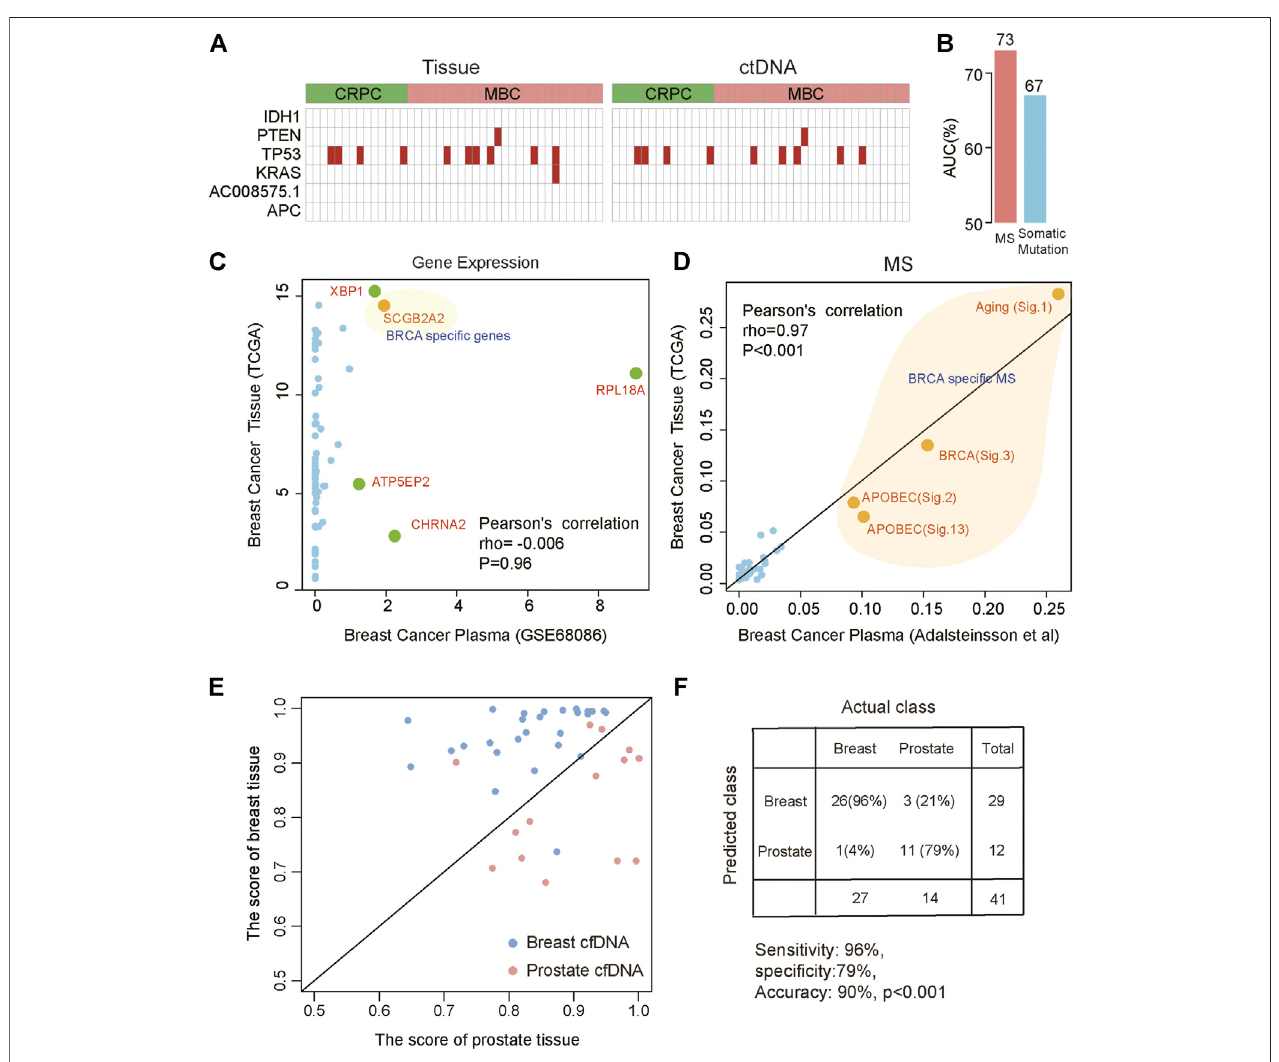
FIGURE 5 | Distinguishing different cancer types based on the MS patterns and somatic mutations called from plasma ctDNA data. (A) The speci fi c mutations in tissue (left) and ctDNA (right). Red indicates that mutation was detected. CRPC: prostate cancer; MBC: metastatic breast cancer. (B) The ef fi ciency of MS and somatic mutations to distinguish lung cancer patients from benign lung nodules patients from ctDNA data. (C,D) The correlation between plasma and tissue in breast cancer based on gene expression (C) and MS (D) . Orange indicates breast cancer-speci fi c markers. (E,F) Combined MS patterns and somatic mutations called from plasmactDNAdatadistinguishbreastcancerandprostatecancer.Theredpointsrepresentprostatecancerandthebluepointsrepresentbreastcancer.Thehorizontal axis represents the score of the prostate cancer model and the vertical axis represents the score of the breast cancer model.